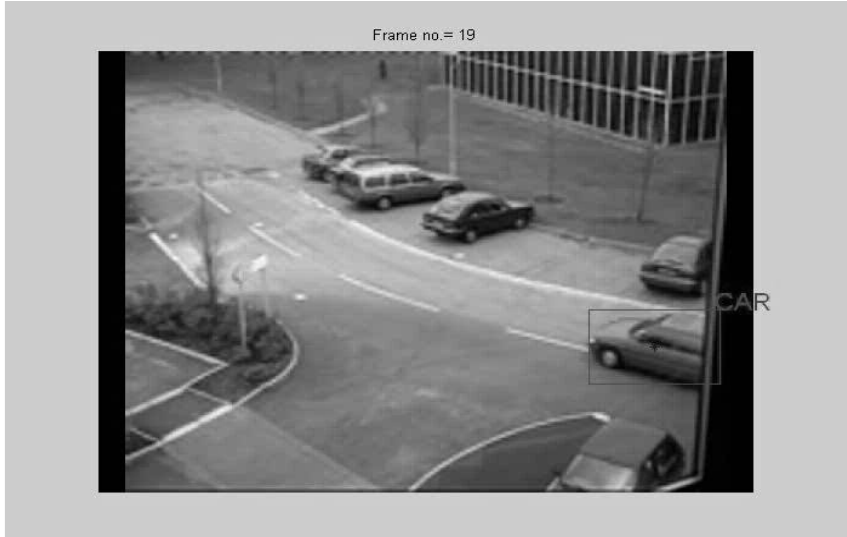
Figure 15. Recognizing object as